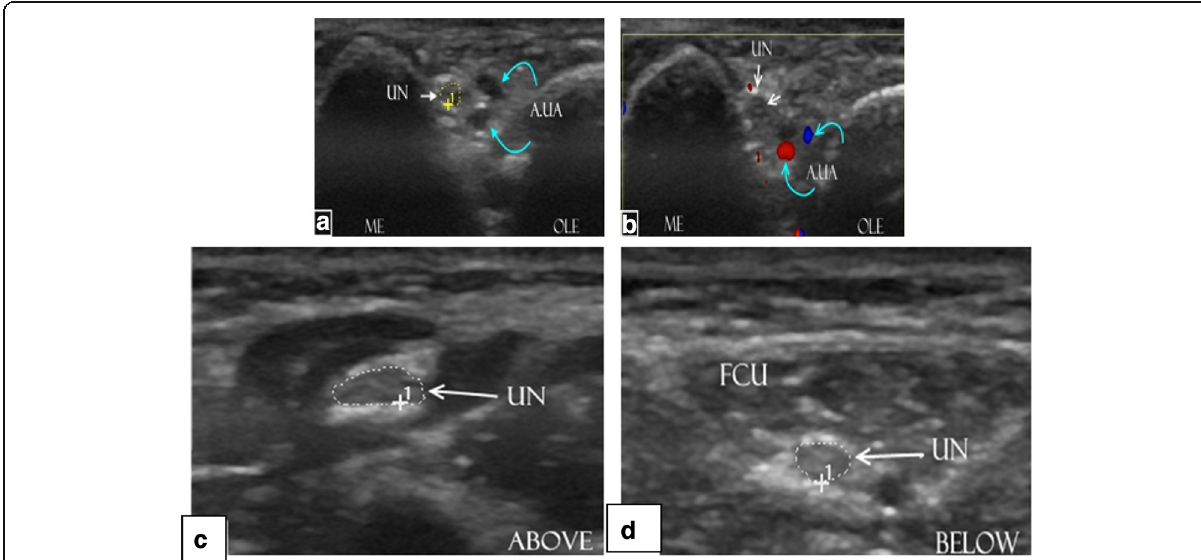
Fig. 4 Dynamic high-resolution ultrasound was done. a Transverse view of the cubital groove shows average CSA of the ulnar nerve (UN) within the cubital groove; two adjacent rounded anechoic structures are seen within the groove (curved green arrows). b Doppler examination of the cubital groove shows the aberrant ulnar artery (A.UA) and its vena comitans within the groove adjacent to the ulnar nerve. c Cross-sectional area of the ulnar nerve (UN) above the elbow (white arrow) which appears swollen evidenced by its increased CSA. d Cross-sectional area of the ulnar nerve (UN) below the elbow (white arrow) shows it is returning to normal. FCU = flexor carpi ulnaris muscle